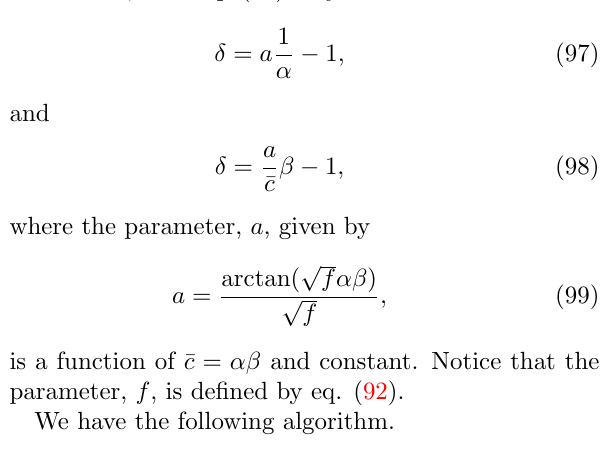
Algorithm 6.1 (Max time delay error